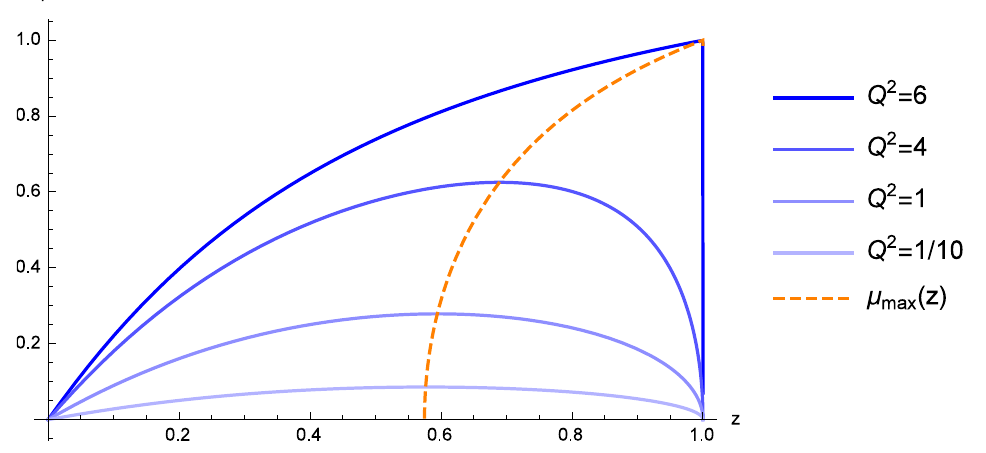
Figure 1 . Local chemical potential in pure AdS-RN for di(cid:11)erent values of Q 2 . The dashed line marks the maximal value, for all di(cid:11)erent values of Q 2 .